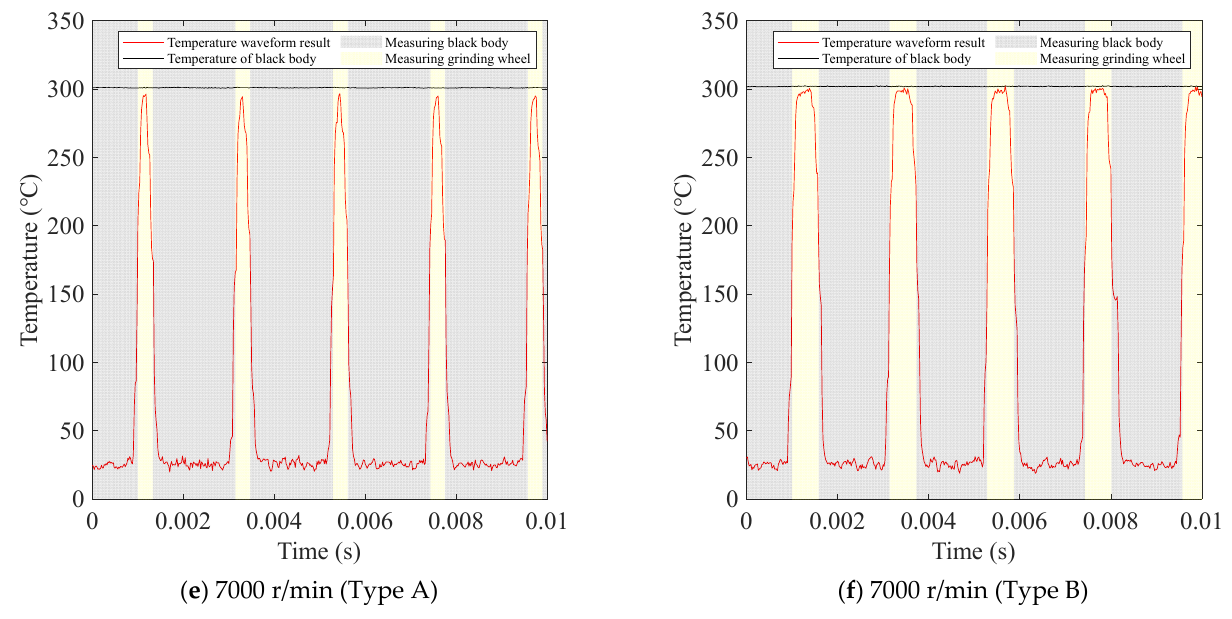
Figure 6. Temperature measurement result on blackbody furnace with different configurations of grinding wheel.